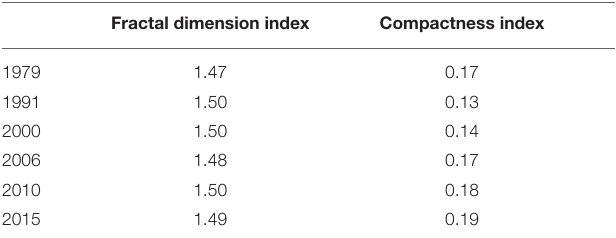
TABLE 4 | Fractal dimension index and compactness index of urban and built area in Siem Reap through 1979 to